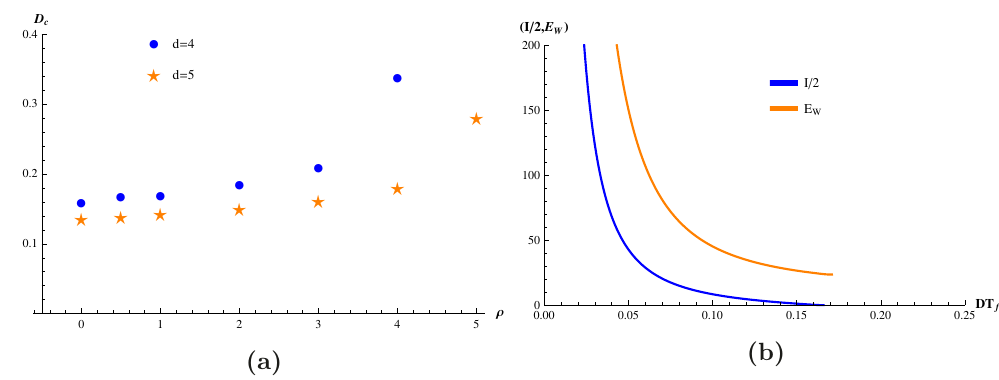
Figure 6. (A) The critical distance D c between two specially disjoint regions increases with ρ for two values of the dimension d = 4 , 5. (B) The corresponding plot shows the variation of E W , I/ 2 with temperature for a fixed ρ = 4 and dimension d = 4. Both E W and I show decreasing behavior with